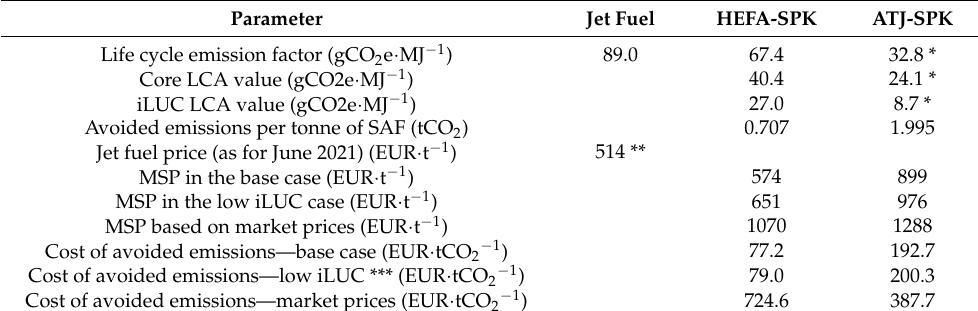
Table 8. Synthesis of the results of the MSP in different cases, and estimates of the avoided costs of GHG